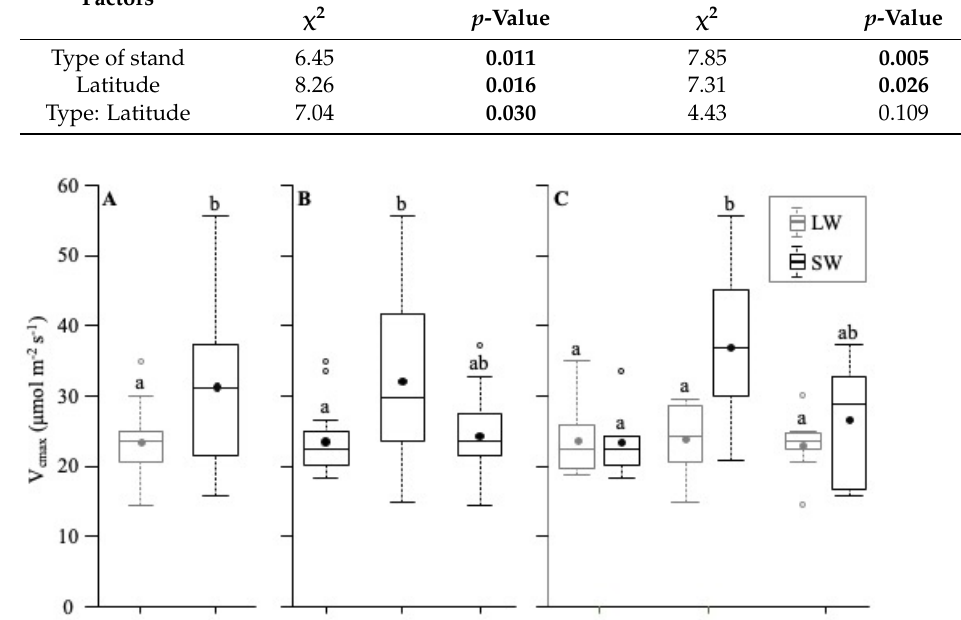
Figure 3. Maximum Rubisco carboxylation rate (V cmax , ( A )–( C )) and maximum electron transport rate (J max , ( D )–( F )) averaged for trees in SMs and LWs for all latitudes ( A , D ), the different latitudes sampled ( B , E ), and the interaction between stand type and latitude ( C , F ). Solid points and letters represent the mean and significant differences from the 5% level (Tukey test), respectively. A max Although SM individuals had a higher physiological capacity than LW individuals, stand type does not appear to affect the net assimilation rate of individuals measured in the field (Table 3). Indeed, the A max of individuals from SM is 4.7 ± 1.8 μ mol m − 2 s − 1 , while that of individuals from LW is 4.4 ± 1.9 μ mol m − 2 s − 1 . Furthermore, unlike the V cmax and J max measurements, the A max measurements did not show a significant difference at the latitudinal level, although it is possible to observe a trend for which the A max of the SMs from latitude 52° N is slightly higher than the values observed in the SMs and LWs from other latitudes. Table 3. Summary of ANOVA result (chi-square and p -value) of maximum photosynthetic rates (A max ), water vapor stomatal conductance (gs), and ambient temperature at the time of measurement (Tambient). Bold p -value indicates significant difference at the 5% threshold. Factors